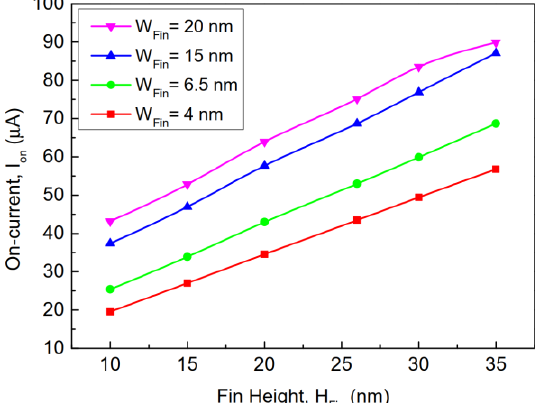
Figure 9. Behavior of the on-current as a function of fin height for FinFET devices with different values of the fin width at V gs = V ds = 0.8 V.